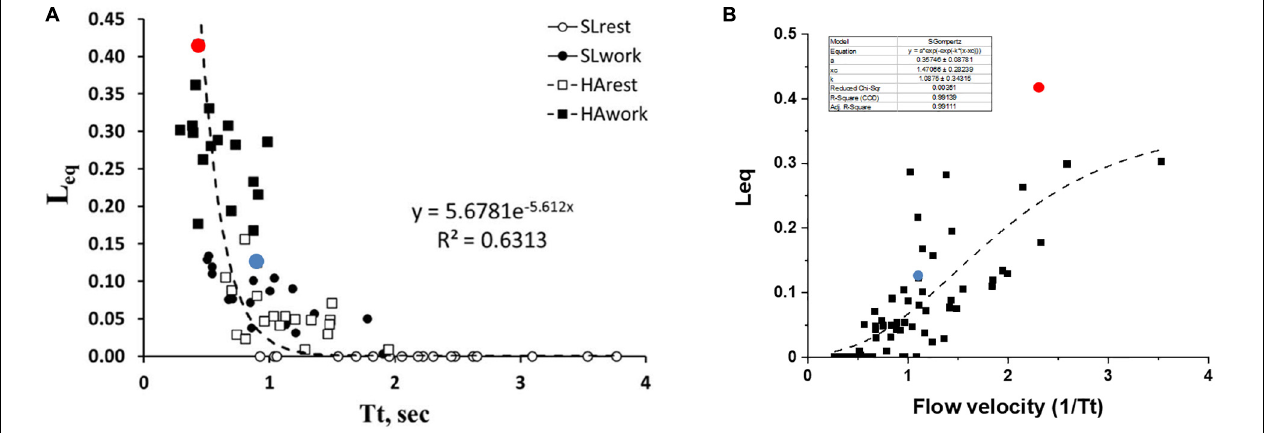
FIGURE 6 | (A) Correlation between transit time ( Tt ) and Leq in various conditions as indicated in the inset. (B) A plot of Leq vs. 1/Tt (an index of blood velocity). Red and blue dots refer to the two subjects shown in Figures 5A,B , respectively (data from Beretta et al., 2019).